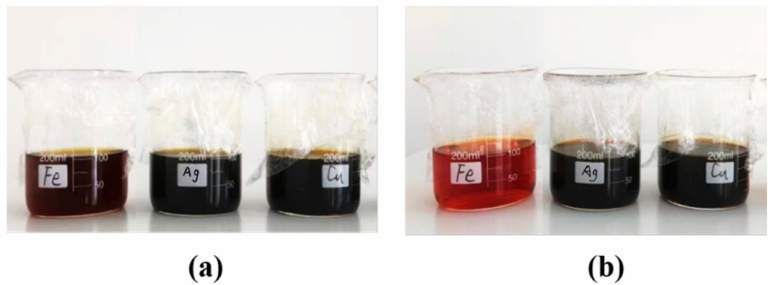
Figure 2. Photographs of Ag, AgCu and AgFe NAs before ( a ) and after ( b ) heating at 80 ◦ C for 4 h. The Ag concentration was 500 ppm for all the samples. The labels Fe, Ag and Cu represent AgFe, Ag and AgCu, respectively.